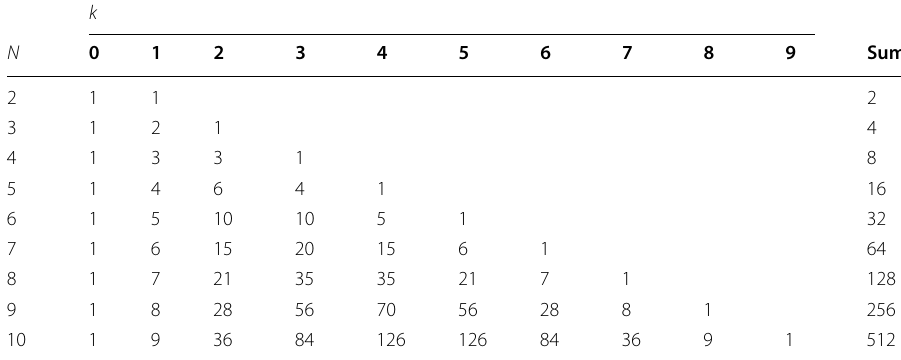
Table 2 Number of unique decomposition forms that correspond to one factor at each step from the polar